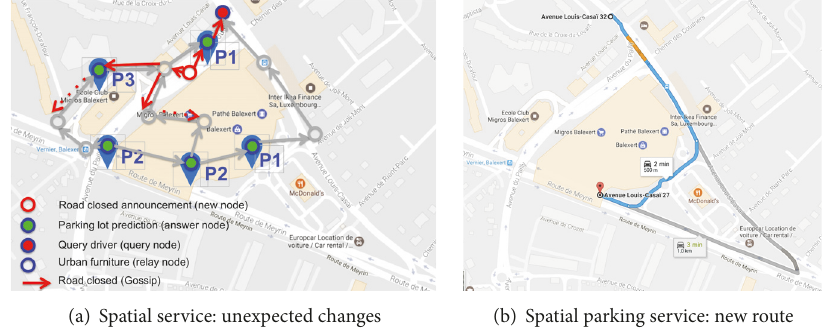
Figure 2: Overview of the intelligent parking space system. The red dotted arrows are the road closed (gossip) just like the solid red lines (it is broken to show that there could be multiple agents in the process); filled blue circles are parking places; and the grey circles are